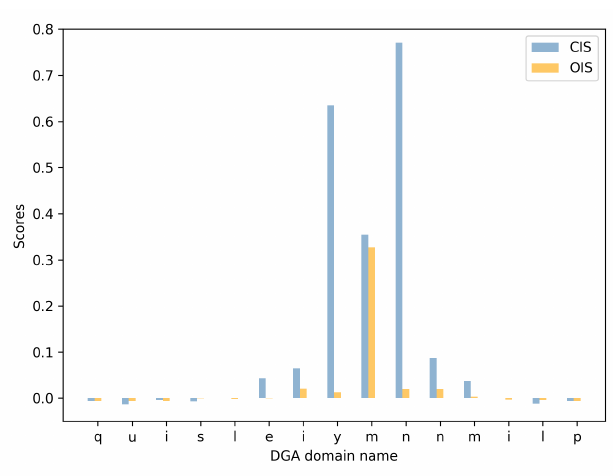
Figure 2. An example of calculating confidence